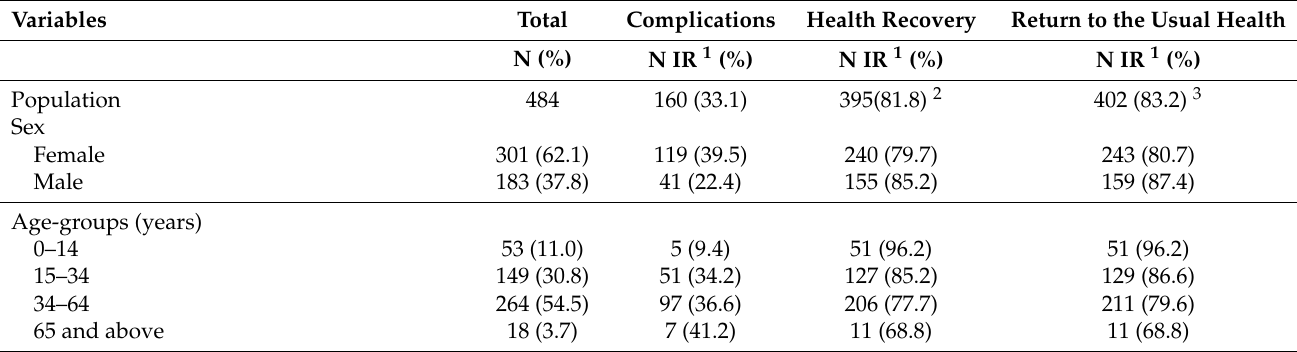
Table 1. Incidence rate (IR) of complications, health recovery, and return to the usual health. Borriana COVID-19 cohort